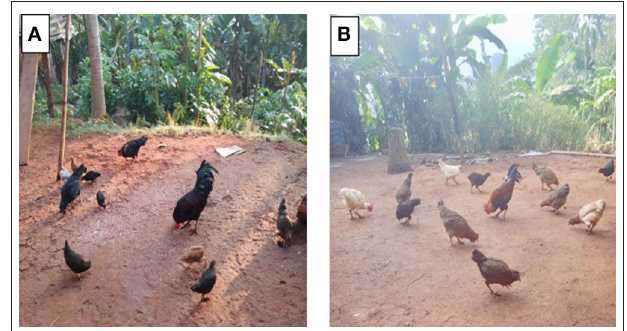
FIGURE 1 | Backyard poultry birds in the villages of Meghalaya in northeastern India comprises of both indigenous germplasm (A) and improved varieties (B) of